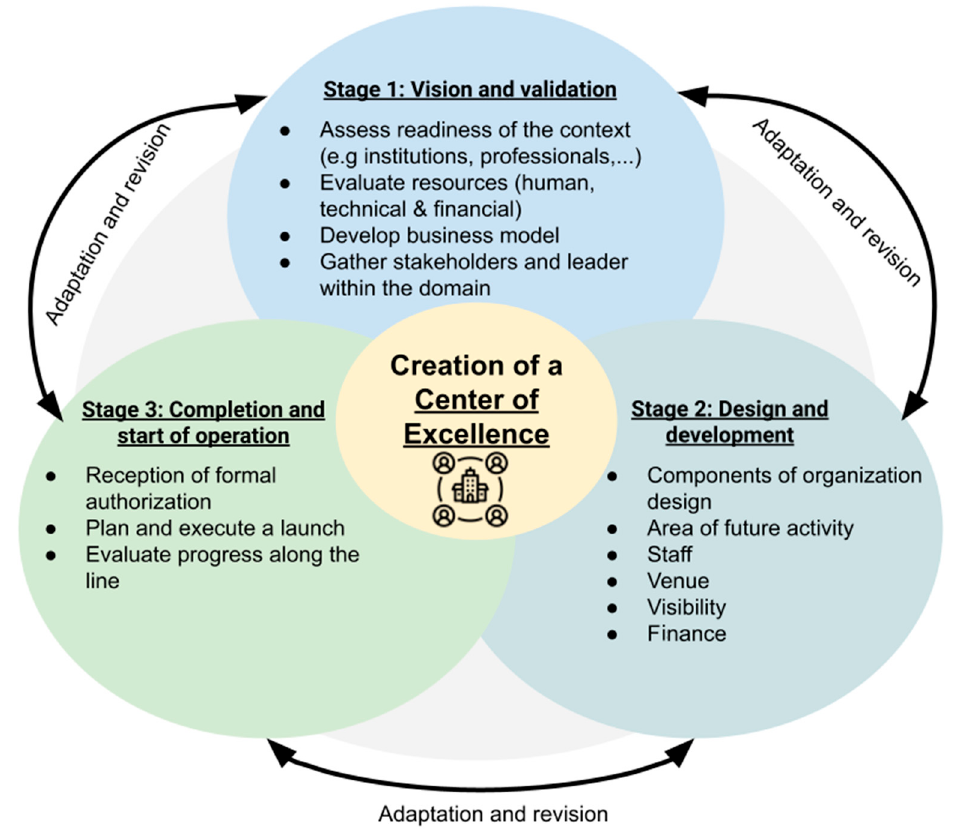
Figure 2. The 3-stage model of creation of a medication adherence research centre of excellence.